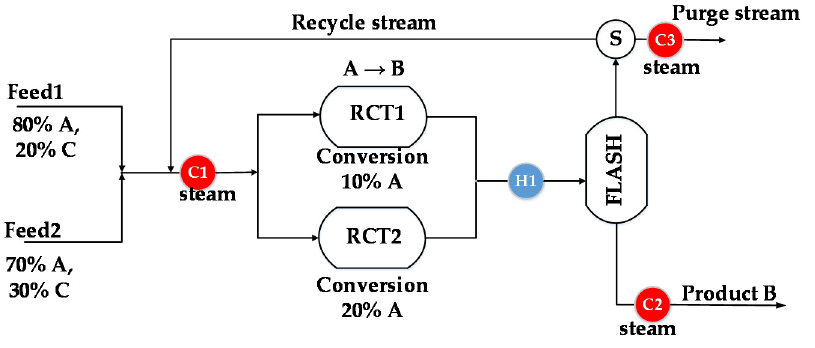
Figure 1. Process superstructure [32].